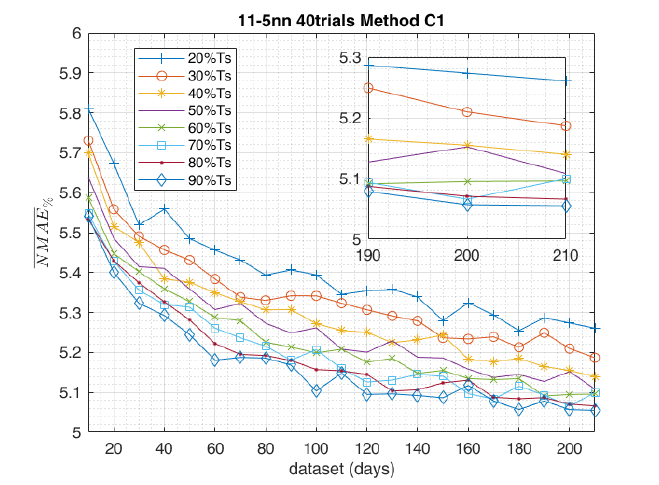
Figure 11. NMAE % as a function of the dataset size.